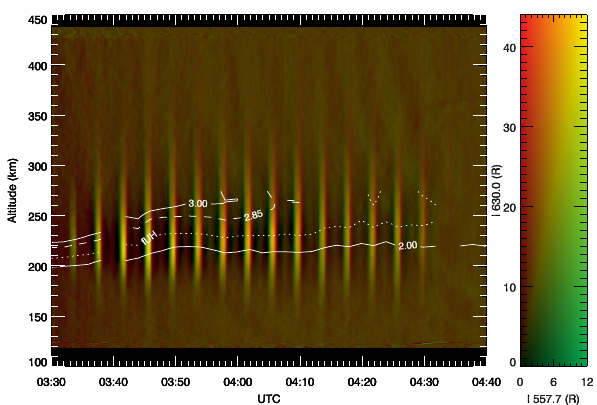
Fig. 5. Calibrated composite color profiles (red=630.0nm, green=557.7nm) of emission intensity vs. altitude along the HAARP field line collected on 4 February 2005 from Poker Flat, Alaska, ∼ 325km from the HAARP site. Plasma frequency con- tours from the HAARP ionosonde, including the transmitter fre- quency of 2.85MHz and the upper hybrid frequency matching the transmitter frequency (“fUH”) have been superimposed on the keogram. The scale at right indicates color as a function of red and green intensities.